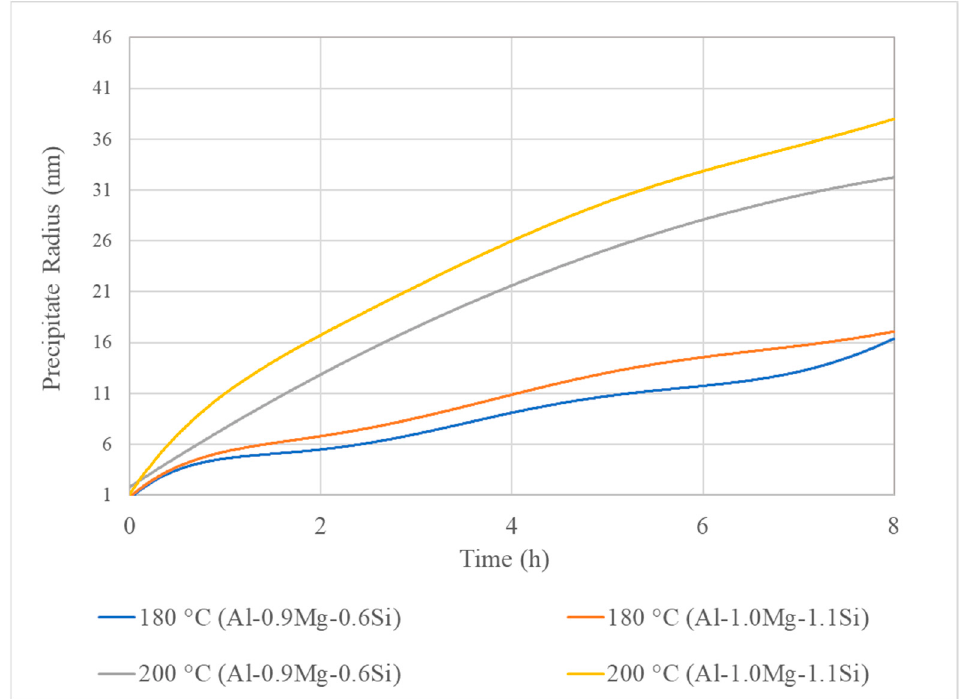
Figure 9. Temporal variation of the precipitate radius.